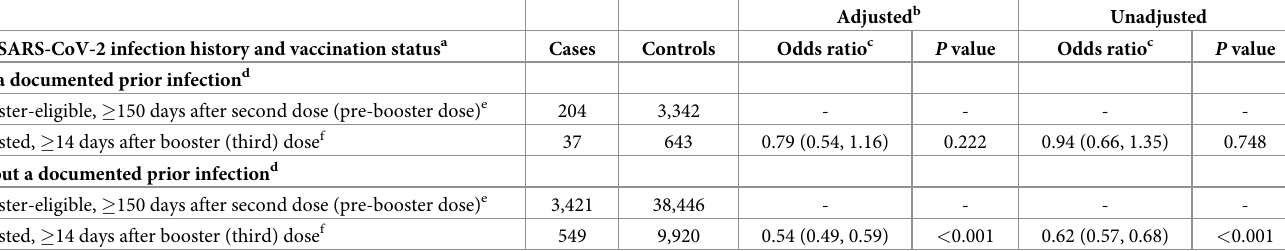
Table 2. Risk of SARS-CoV-2 Omicron (BA.1 lineage) variant infection among people who received booster vaccination relative to booster-eligible people, accord- ing to history of a documented prior SARS-CoV-2 infection.